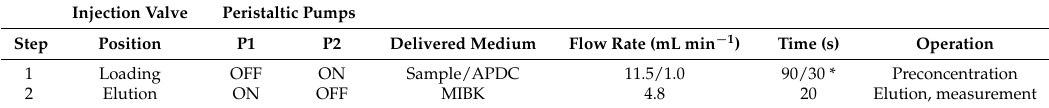
Table 1. Main operation sequences of the FI-FDSE-FAAS method for metal determination. Injection Valve Peristaltic Pumps Step